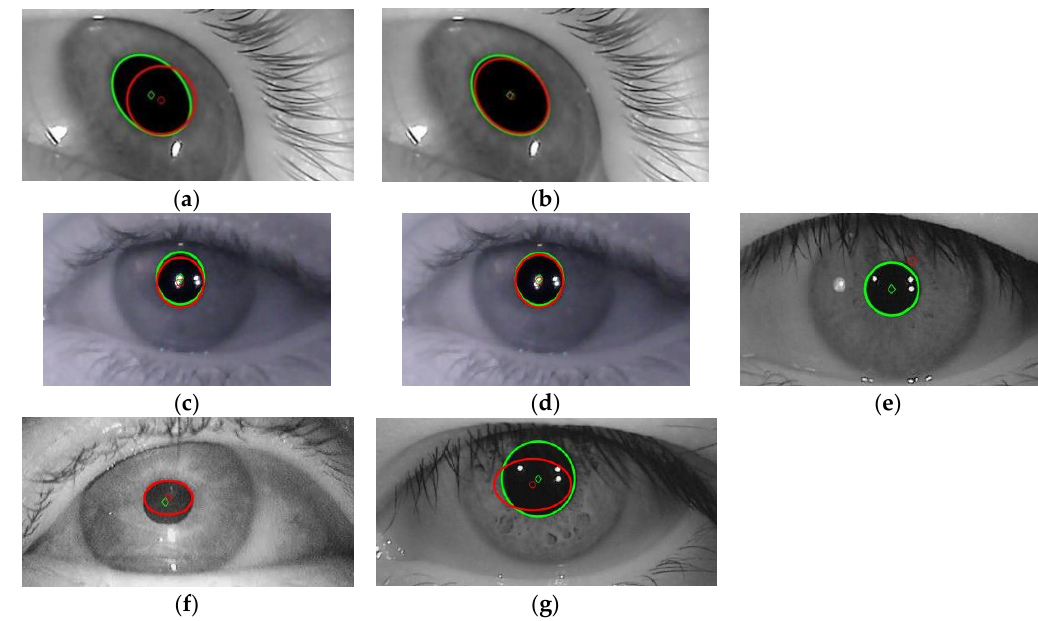
Figure 9. Typical detection errors of analyzed PDAs: ( a ) CHT, detection error due to elliptical shape of the pupil; ( b ) EHT, canceling the error introduce by CHT algorithm; ( c , d ) RANSAC, two different runnings on the same eye image with corneal reflection; ( e ) ExCuSe, loss of detection in an image affected by corneal reflection and occluded by eyelashes; and ( f ) PROJ and ( g ) LSFE, images sensitive to binarization stage (noisy eye image or pupil with occlusions). Legend: Green line—ideal pupil contour and center; red line—detected pupil contour and center.